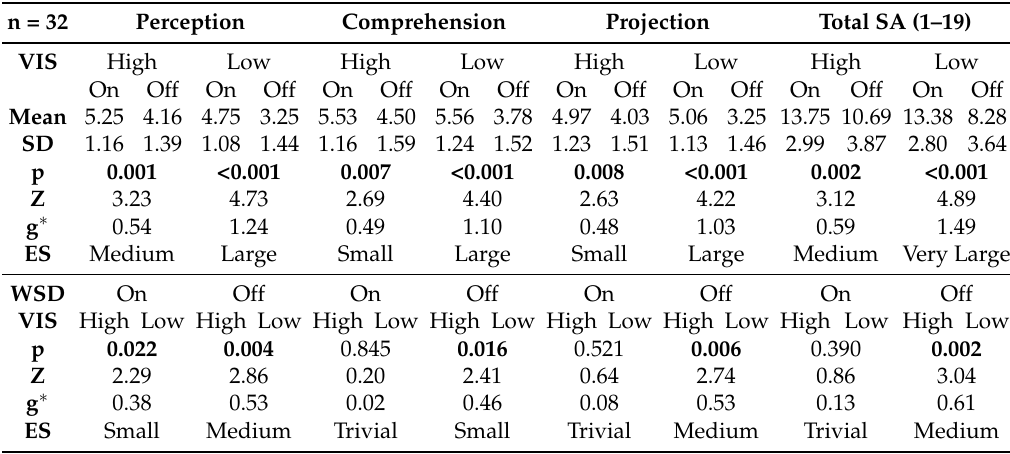
Table 4. Results of the Wilcoxon–Pratt signed-rank tests for SA self-ratings. Results are grouped by Endsley’s SA levels. Total SA score equals the sum of all three self-ratings with offset correction of − 2. The upper section compares trials with and without WSD interface; the lower section compares runs with bad and good visibility levels. Effect size (ES) is given as Hedges’ g with bias correction for small samples (g ∗ ) and interpreted with thresholds (0.2, 0.5, 0.8, 1.3) of Cohen and Rosenthal